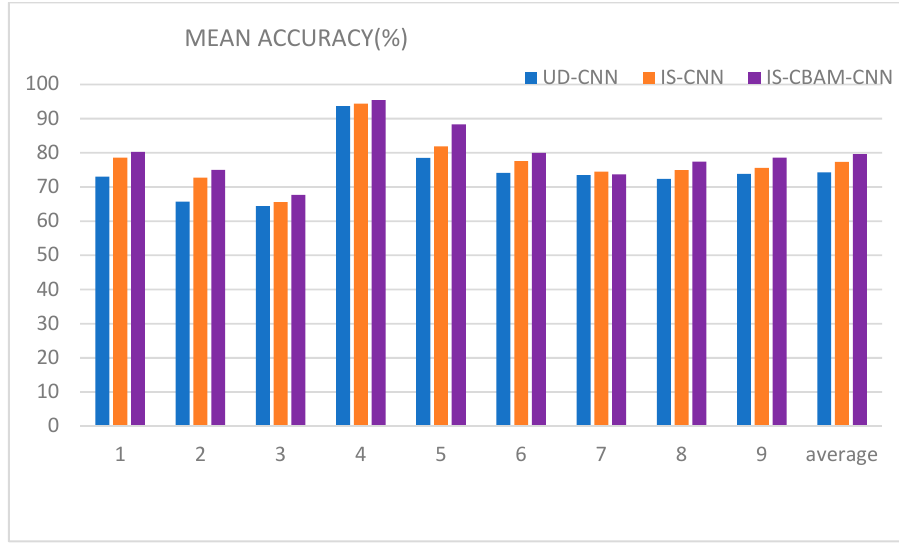
Figure 6. Comparison of the accuracy results of UD-CNN, IS-CNN, and IS-CBAM-CNN.